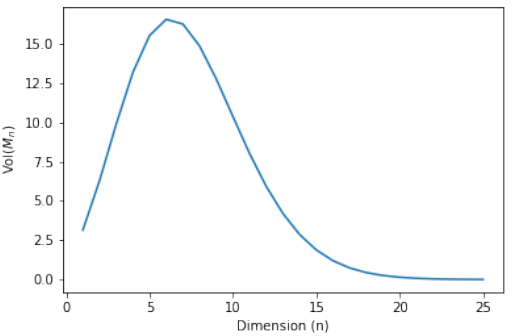
Figure 3. Volume of the family of multinomial distributions as dimension